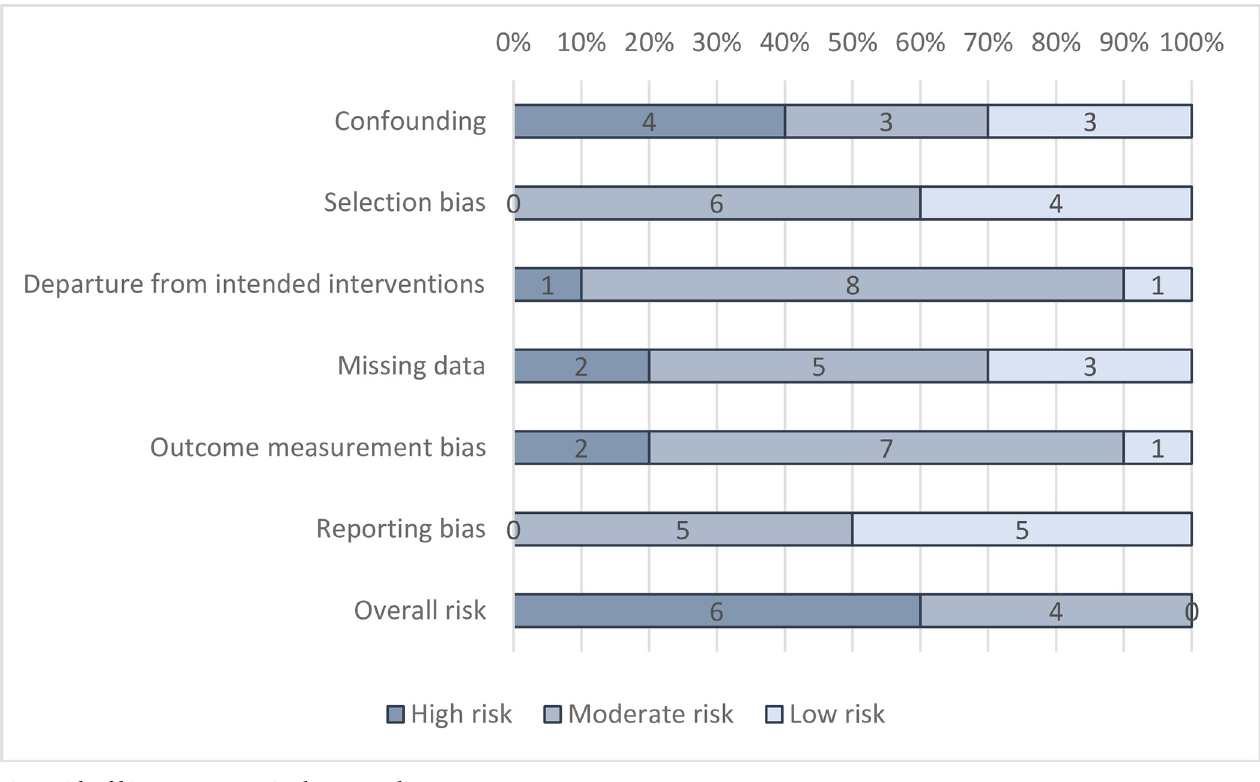
Fig 3. Risk-of-bias assessment: Diarrhoea